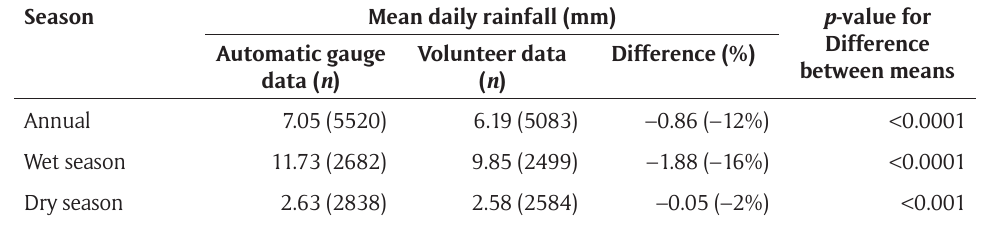
Table 4: Comparison of automatic gauge and volunteer data by season, with p -values from results of paired t-tests.